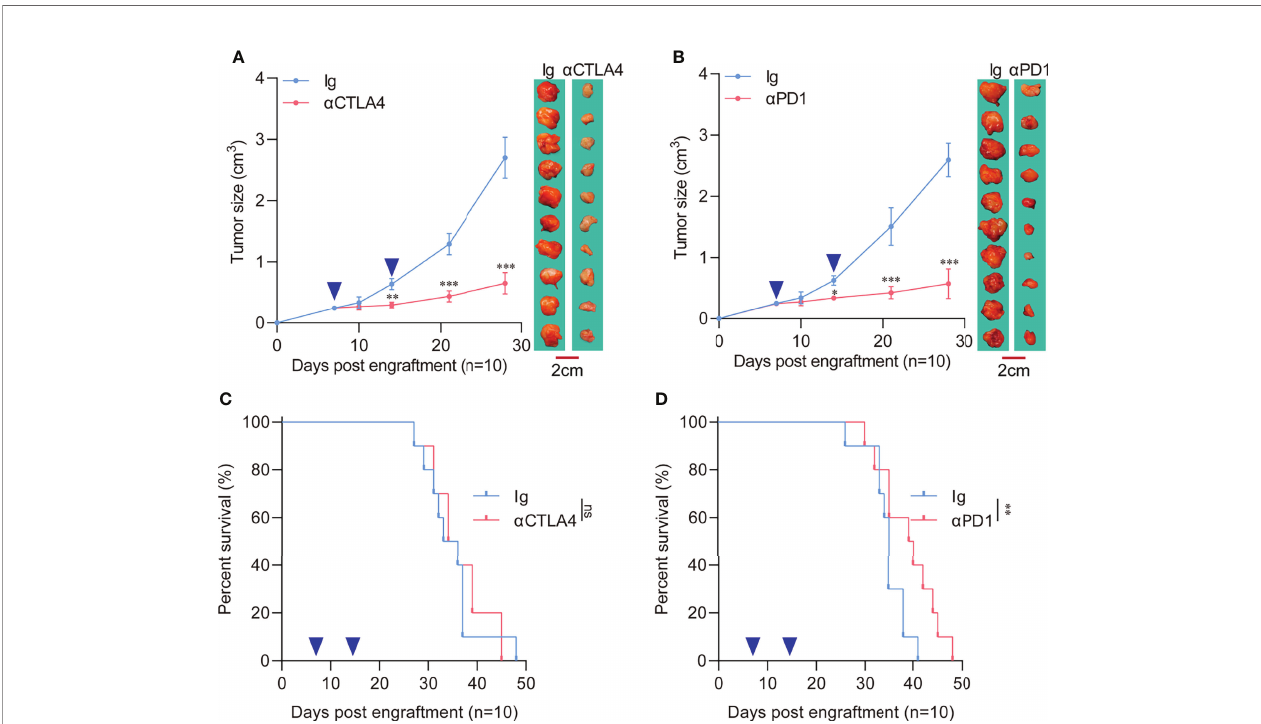
FIGURE 3 | Response of heterotopic or orthotopic engraftment tumors to immune checkpoint blockade therapy. (A) Heterotopic tumor-bearing C57 mice were randomly assigned to 2 groups and treated with an anti-CTLA4 antibody (10 mg/kg) or an isotype-matched control antibody. Heterotopic fl ank tumor size was assayed after treatment. The blue arrows indicate anti-CTLA4 antibody or control Ig administration. (n=10 each, compared with Ig group, **P<0.01, ***P<0.001). (B) Heterotopic tumor-bearing C57 mice were randomly assigned to 2 groups and treated with an anti-PD1 antibody (10 mg/kg) or an isotype-matched control antibody. Heterotopic fl ank tumor size was assayed after treatment. The blue arrows indicate anti-PD1 antibody or control Ig administration. (n=10 each, compared with Ig group, *P<0.05, ***P<0.001). (C) Survival of orthotopic tumor recipients after anti-CTLA4 treatment. The blue arrows indicate anti-CTLA4 antibody or control Ig administration (n=10 each, compared with Ig group). (D) Survival of orthotopic tumor recipients after anti-PD1 treatment. The blue arrows indicate anti-PD1 antibody or control Ig administration (n=10 each, compared with Ig group,